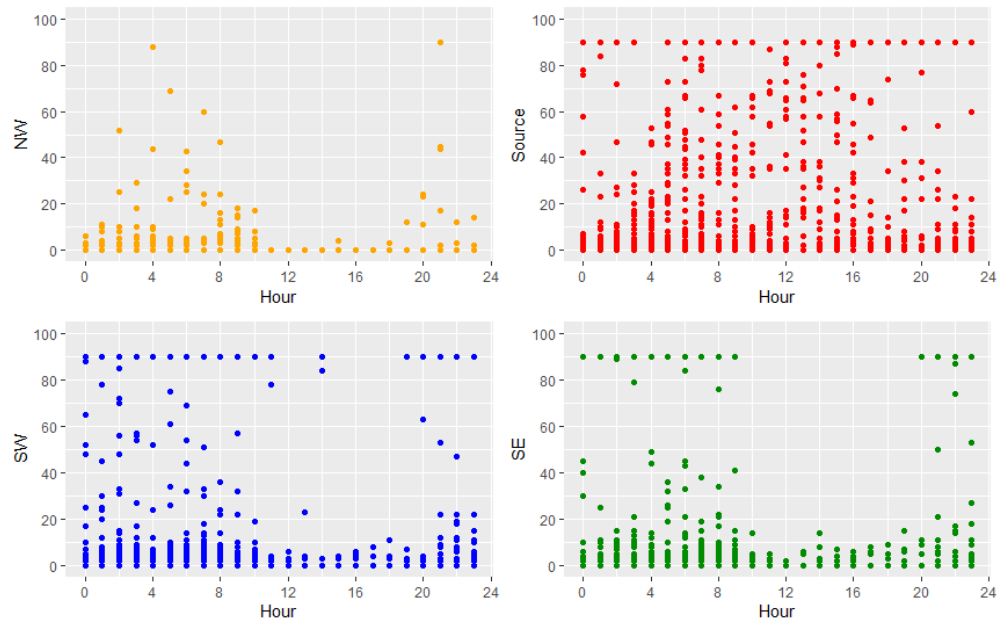
Figure 4. Hydrogen sulfide concentration measurements (ppb) based on time of day during the monitoring period for the dairy case study at monitoring points NW of the dairy ( upper left ); near the manure storage of the dairy ( upper right ); SW of the dairy ( lower left ); and SE of the dairy ( lower right ) . More than 90% of the H 2 S concentration measurements at the three receptors were less than 20 ppb. The H 2 S concentrations tended to exceed 20 ppb overnight between 20:00 and 08 : 00. Neutral and